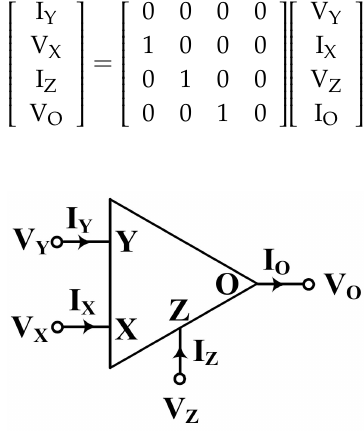
Figure 1. Schematic symbol of